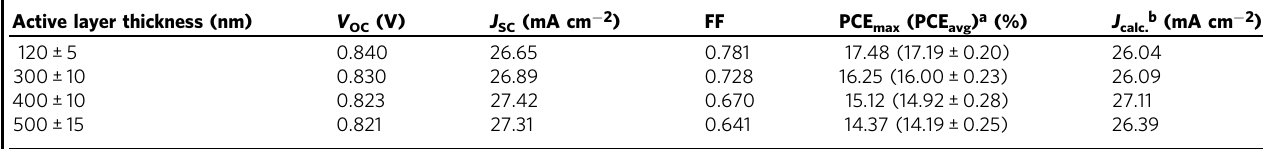
The errors are de fi ned as standard deviation. a Average PCE from ten independent cells. b denotes integrated J SC from the EQE curves.